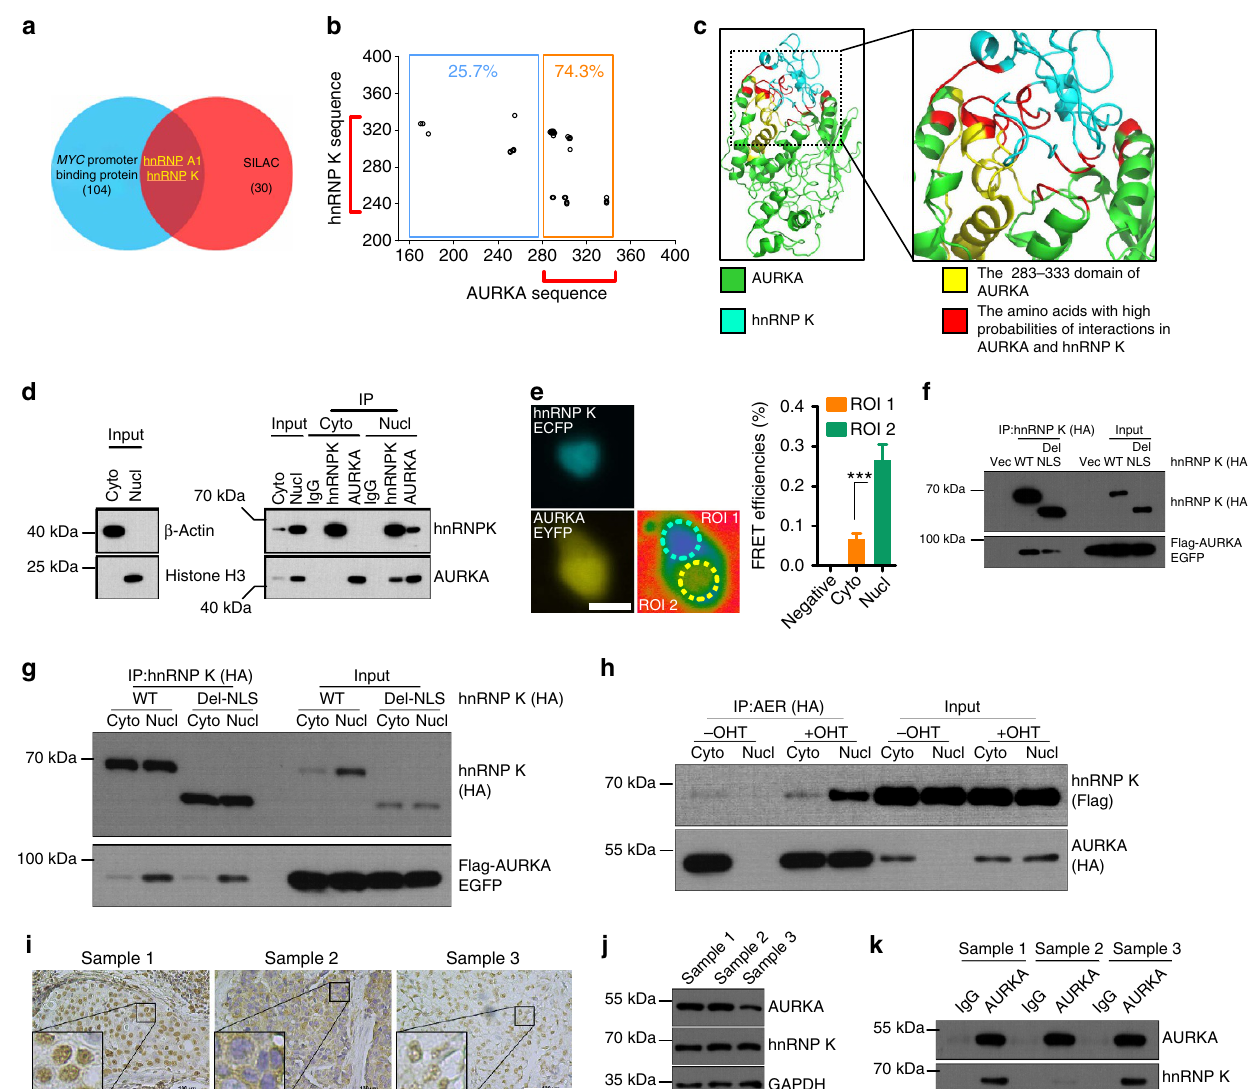
Figure 3 | AURKA and hnRNP K efficiently interacts in the nucleus. ( a ) AURKA-interacting proteins were identified using SILAC assay (red area). MYC promoter-regulating proteins were previously reported (blue area). Proteins presented in both categories were selected for further analysis. ( b ) Thirty-five combinations of the amino acid derived from AURKA and hnRNP K with high probabilities of interactions were used to compile a dot plot. The amino acids in orange box were located in the nucleotide 283–333 region of the AURKA sequence. ( c ) The simulated interaction diagram of AURKA and hnRNP K. KI domain was shown. ( d ) Nuclear/cytoplasmic protein fractions of MDA-MB-231 cells were subjected to IP and immunoblotting (IB) using antibodies as indicated. ( e ) hnRNP K-ECFP- and AURKA-EYFP-co-transfected 293Tcells were subjected to FRET efficiency analysis. ROI1 and ROI2 were selected for the analysis in the cytoplasmic and nuclear regions, respectively. Enhanced cyan fluorescent protein (ECFP)- and enhanced yellow fluorescent protein (EYFP)-co-transfected cells were used as negative controls. Scale bar, 50 m m. ( f ) Twenty micrograms of WTor NLS deletion mutant hnRNP K were co-transfected with Flag-AURKA–enhanced green fluorescent protein (EGFP) into 293T cells for 24h. Cells were then subjected to IP and IB using antibodies as indicated. ( g ) Twenty micrograms of WT or NLS deletion mutant hnRNP K were co-transfected with Flag-AURKA–EGFP in 293T for 24h. Cytoplasmic and nuclear proteins were separated and subjected to IP and IB using antibodies as indicated. ( h ) Twenty micrograms of AER was co-transfected with Flag-tagged hnRNP K into 293T cells. After 6h, AURKA nuclear translocation was induced by treatment with 200nM OHT for 18h. Cytoplasmic and nuclear proteins were then separated and subjected to IP and IB using antibodies as indicated. ( i ) Samples 1–3 were subjected to IHC staining of AURKA. Scale bar, 100 m m. ( j ) The lysates of samples 1–3 were subjected to IB using antibodies as indicated. ( k ) The lysates of samples 1–3 were subjected to IP and IB using antibodies as indicated. Bars represent the means ± s.e.m. of three independent experiments (analysis of variance (ANOVA) followed by least significant difference (LSD) test; * P o 0.05, ** P o 0.01, *** P o